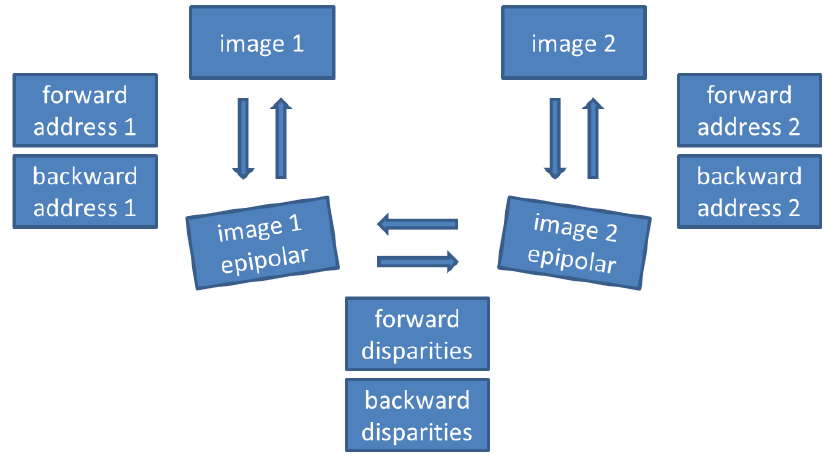
Figure 8. Relation of stereo input images, their epipolar rectified versions, forward and backward addresses and both disparity maps. Boxes represent images and arrows the geometric transformation between